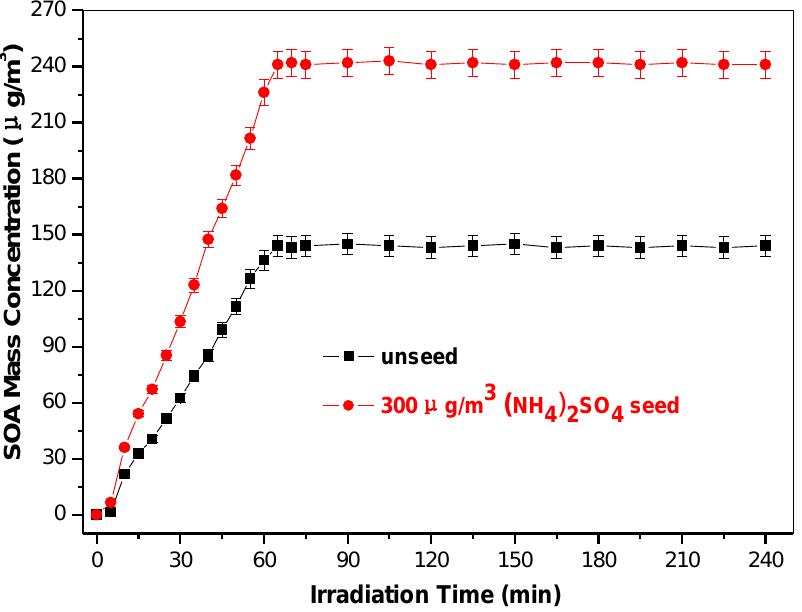
Figure 2. The corrected mass concentration of toluene secondary organic aerosol (SOA) formed in absence of seed and in presence of 300 µ g / m 3 (NH 4 ) 2 SO 4 seed as a function of reaction time.